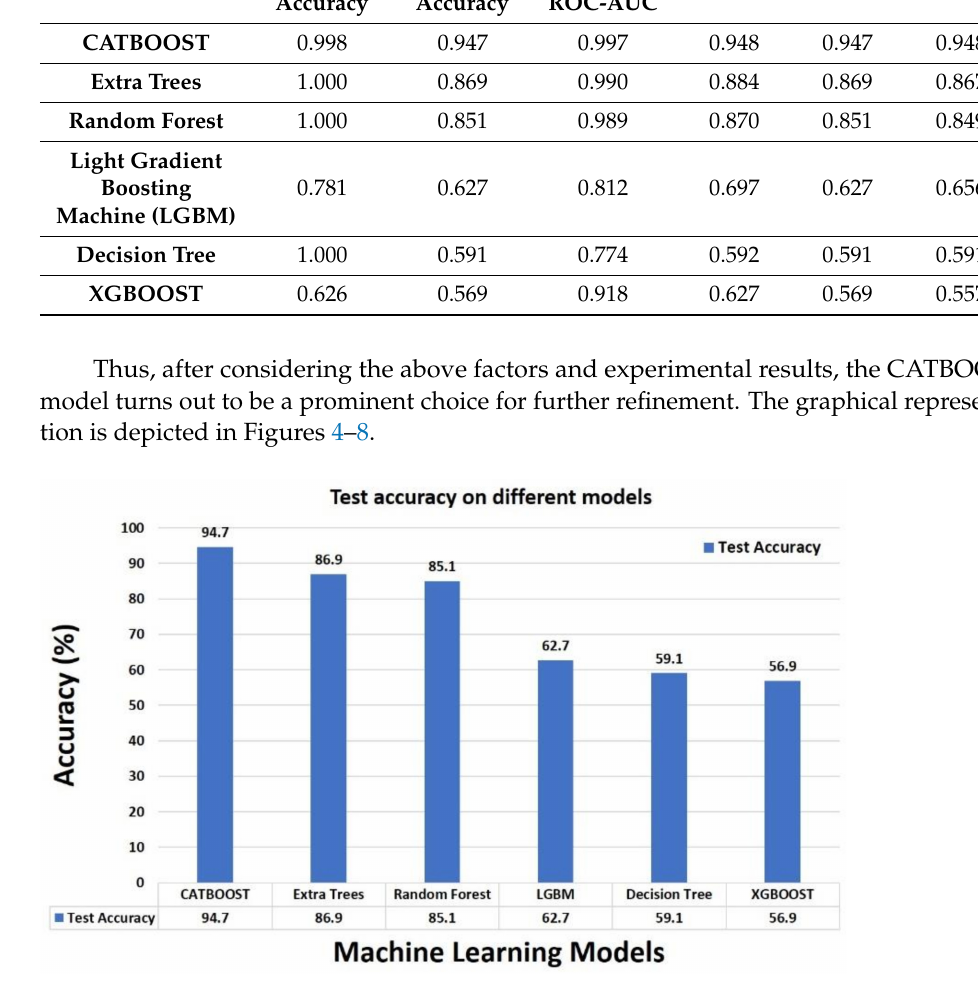
Figure 4. Baseline model test accuracy comparison.